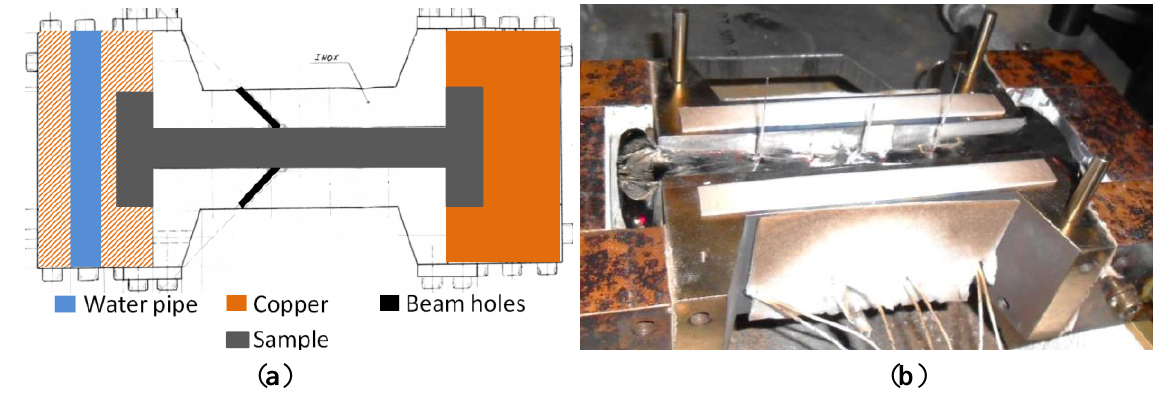
Figure 1. ( a ) Mould design; ( b ) Dog bone shaped